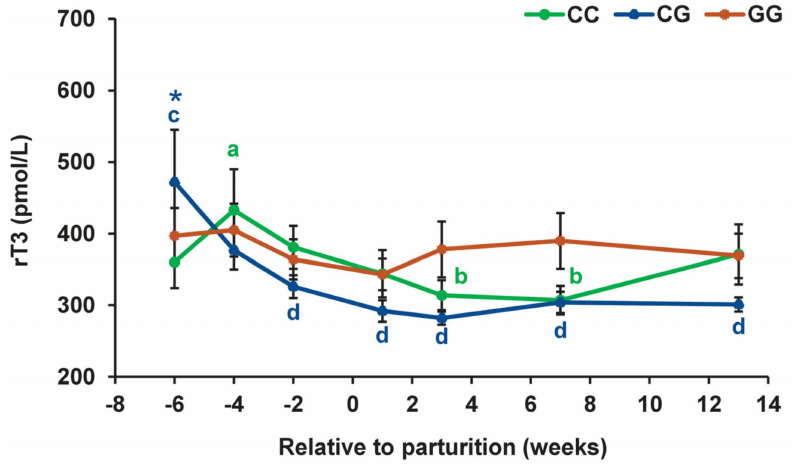
Figure 5. Serum reverse triiodothyronine (rT3) concentrations during the prepartum and postpartum periods in dairy cows with polymorphic variants of the DIO1 gene. Means with different letters differ significantly within each group (at least p < 0.05). * p < 0.05 (between CC and CG